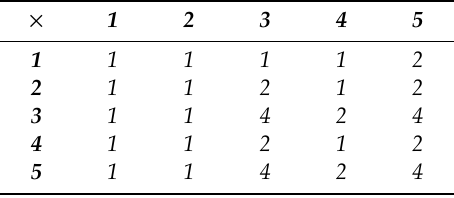
Table 7. The operation × on S .